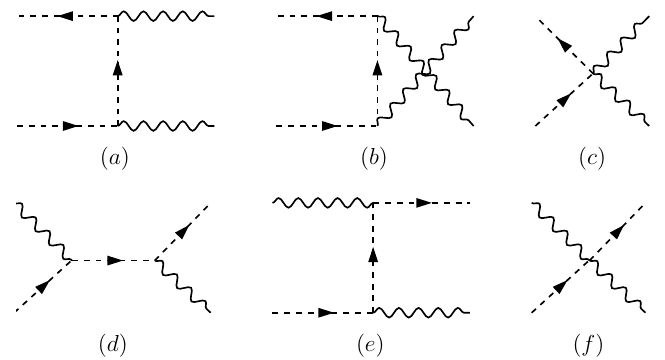
Figure 1 . Feynman diagrams for the scattering processes φ − φ + → A φ − A → φ − A ( φ − A → φ − A ) in 3d topological massive scalar P P T T